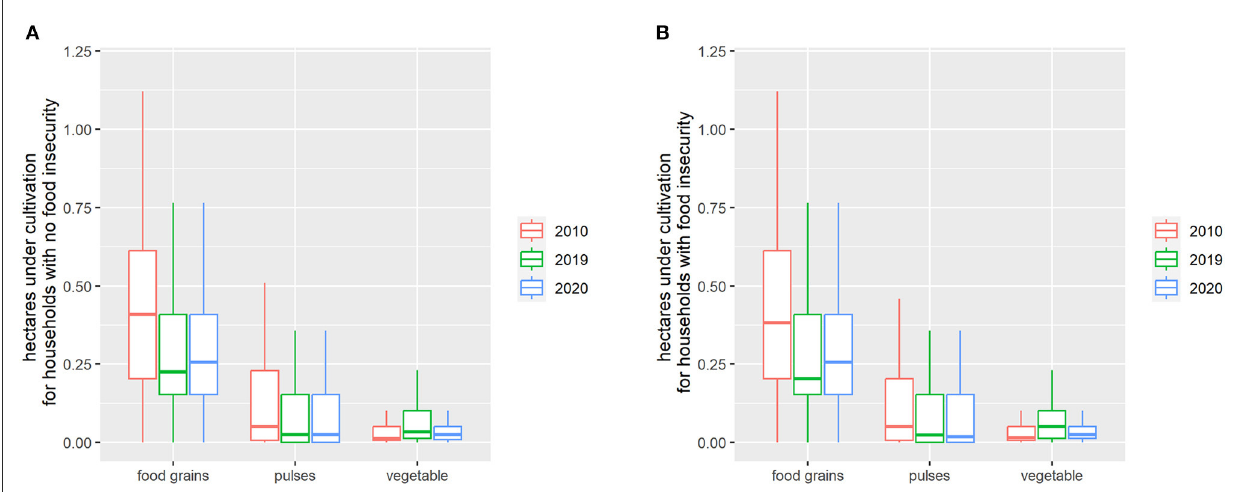
FIGURE5 Change in land under cultivation before and during pandemic. Land under subsistence food grains decreased from 2010 (10 years before the survey) to 2019 (the year before COVID restrictions). In contrast, commercial vegetable production increased. Following the pandemic, vegetables decreased while subsistence food grain production increased marginally—including for those not experiencing food insecurity (A) but especially for those experiencing food insecurity (B) .